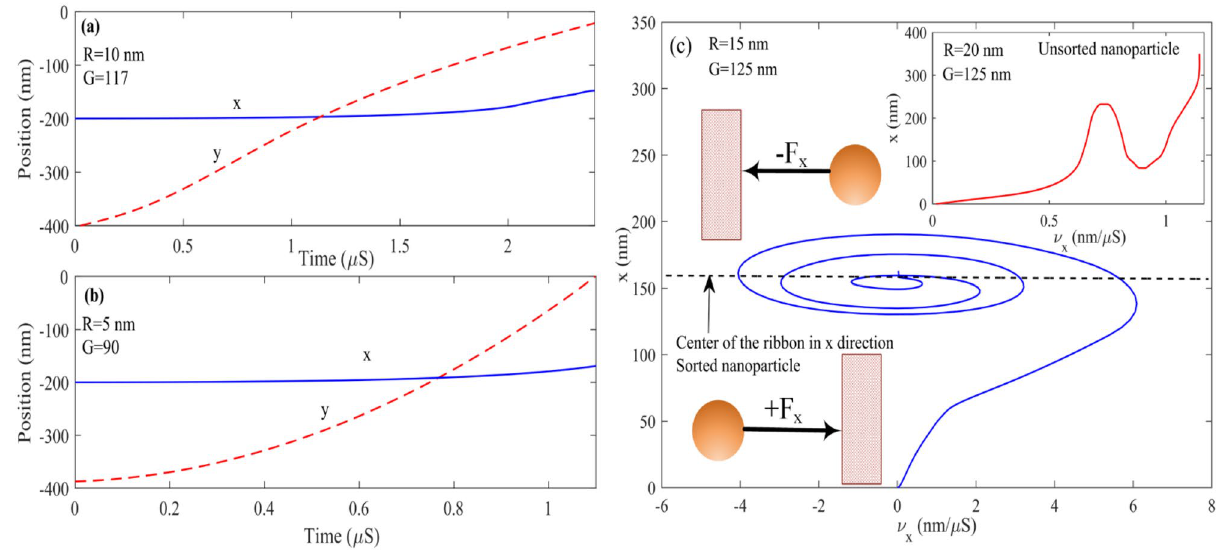
Figure 14. Displacement of nanoparticle with ( a ) R = 10 and G = 117 ( b ) R = 5 and G = 90 when the RI of nanoparticle is n = 1.5. ( c )Velocity of nanoparticle with R = 15 nm and R = 20 nm with G = 125.